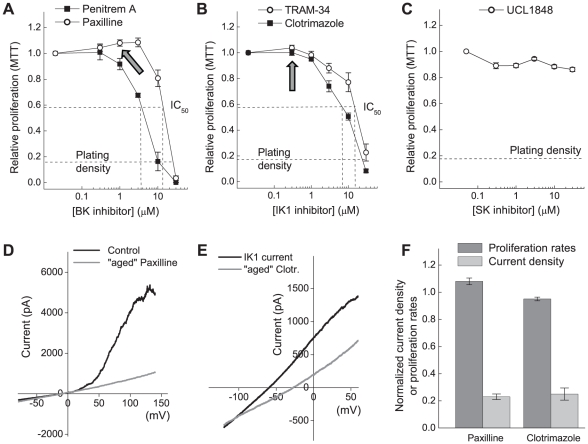
Blockers of the Ca2+-activated potassium channels BK and IK1 suppress proliferation of U251 cells in a dose dependent fashion.(A) Dose response curves for the effects of the BK channel inhibitors, paxilline and penitrem A, on proliferation of U251 cells. Arrow indicates concentration of paxilline that was used to block K+ currents in the electrophysiology experiments presented in (D). (B) Dose response curves for the effects of the IK1 channel inhibitors, clotrimazole and TRAM-34, on proliferation of U251 cells. Arrow indicates concentration of clotrimazole that was used to block K+ currents in the electrophysiological experiments presented in (E). (C) Dose response curves for the effects of the selective SK1-3 channel blocker UCL1848 on proliferation of U251 cells. (D) Effect of the “aged” paxilline on the whole-cell BK currents. Cell proliferation medium containing 10 µM paxilline was collected after 24-hr incubation in cell proliferation assays, diluted 10-fold with electrophysiological bath solution, and used for inhibiting BK currents. Nominal concentration of paxilline was 1 µM (indicated by arrow in (A), to compare proliferation and electrophysiology data). Representative of three experiments. (E) Effect of the “aged” clotrimazole on the whole-cell IK1 currents. Cell proliferation medium containing 10 µM clotrimazole was collected after 24-hr incubation in cell proliferation assays, diluted 10-fold, and used for inhibiting IK1 currents. Nominal concentration of clotrimazole was 1 µM (indicated by arrow in (B)). Representative of three experiments. (F) Comparison of normalized effects of the “aged” paxilline and clotrimazole on the whole cell K+ currents to their effects on cell proliferation. Inhibition of BK and IK1 currents was calculated as average inhibition of the whole K+ cell currents at +140 and 0 mV for BK and IK1, respectively.